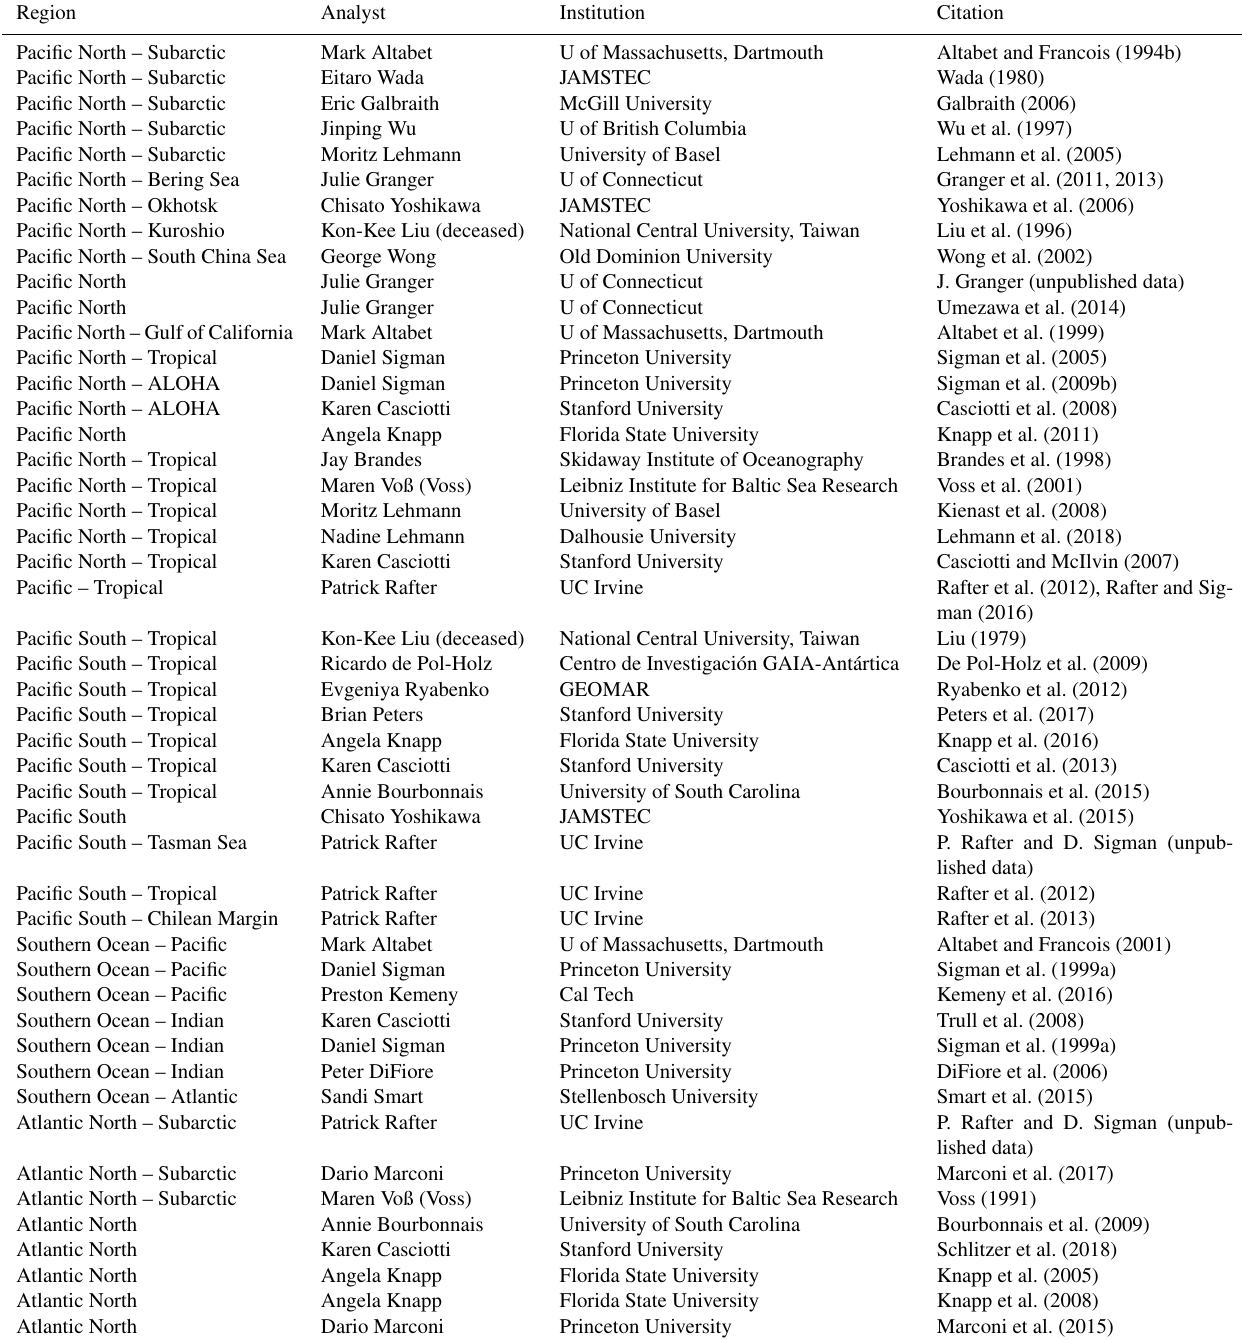
Table A1. Contributing analysts and references for citing original data